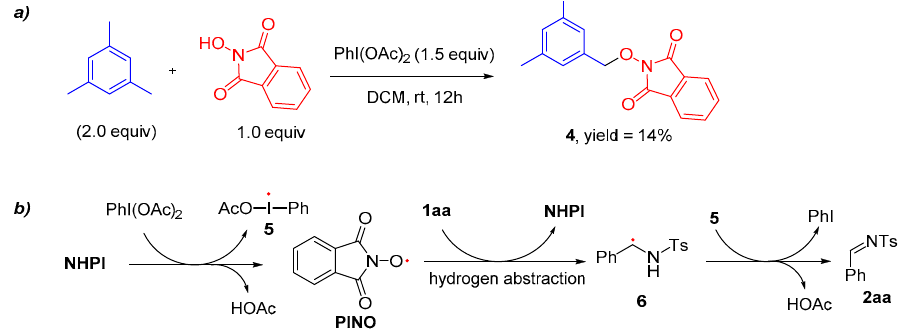
Figure 5. Radical scavenging experiment and proposed mechanism.